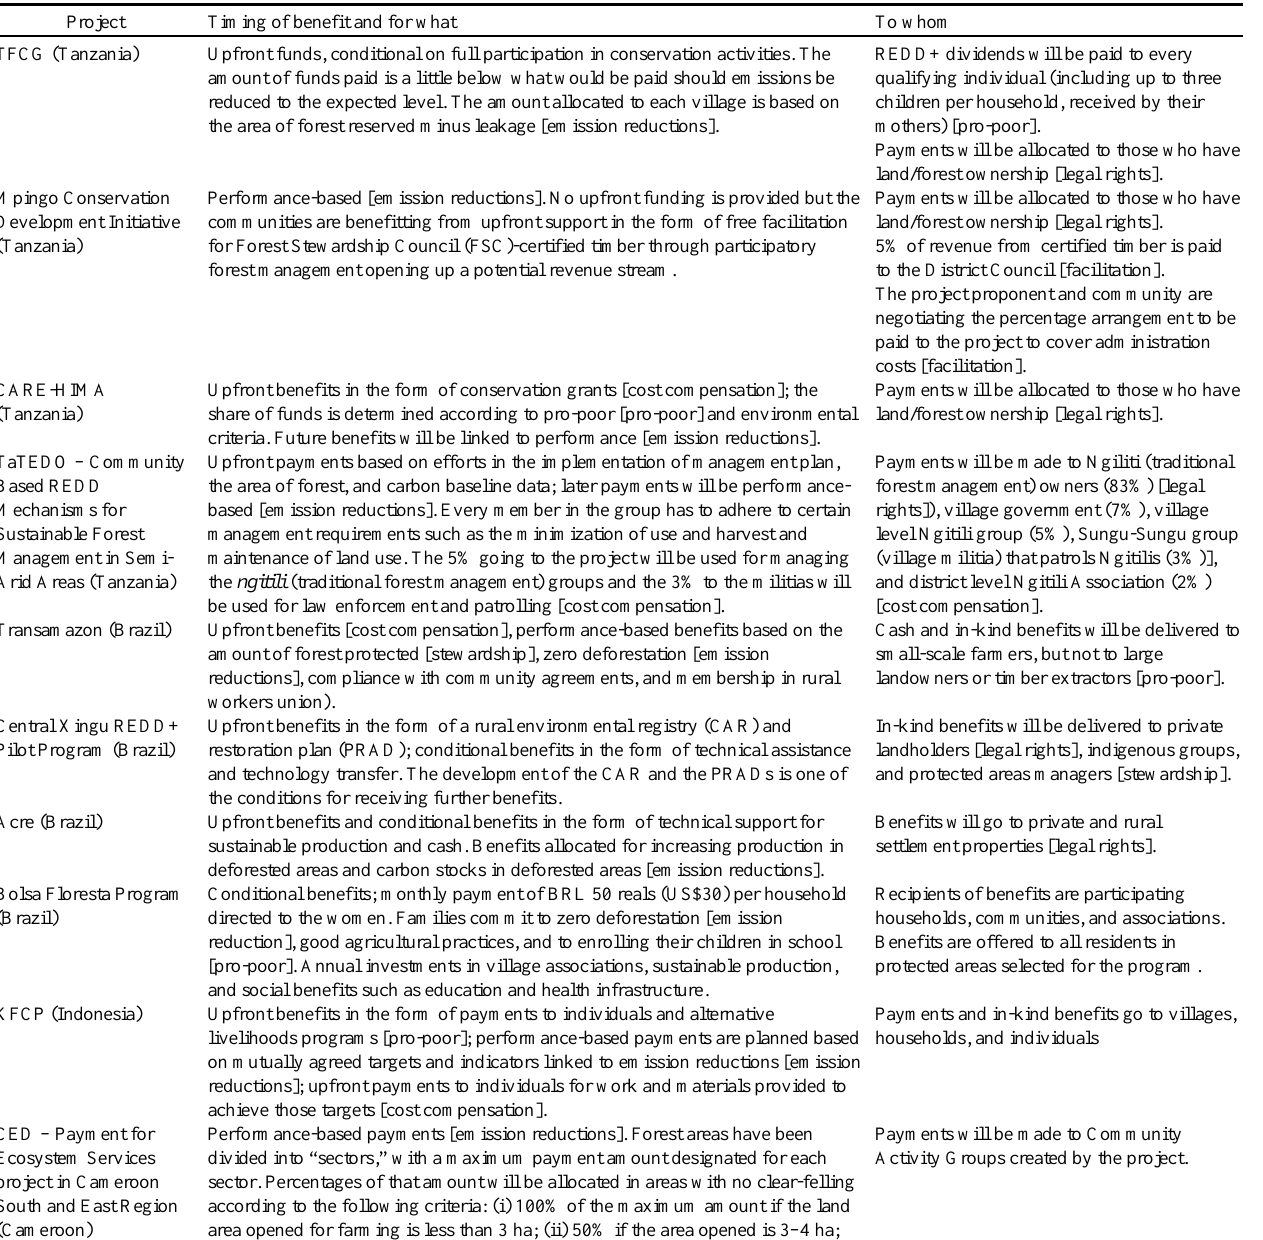
Table 4 . Plans for sharing of benefits and the associated rationales [in brackets] in 10 REDD+ projects. Projects were selected for this table to reflect a range of benefit-sharing rationales.